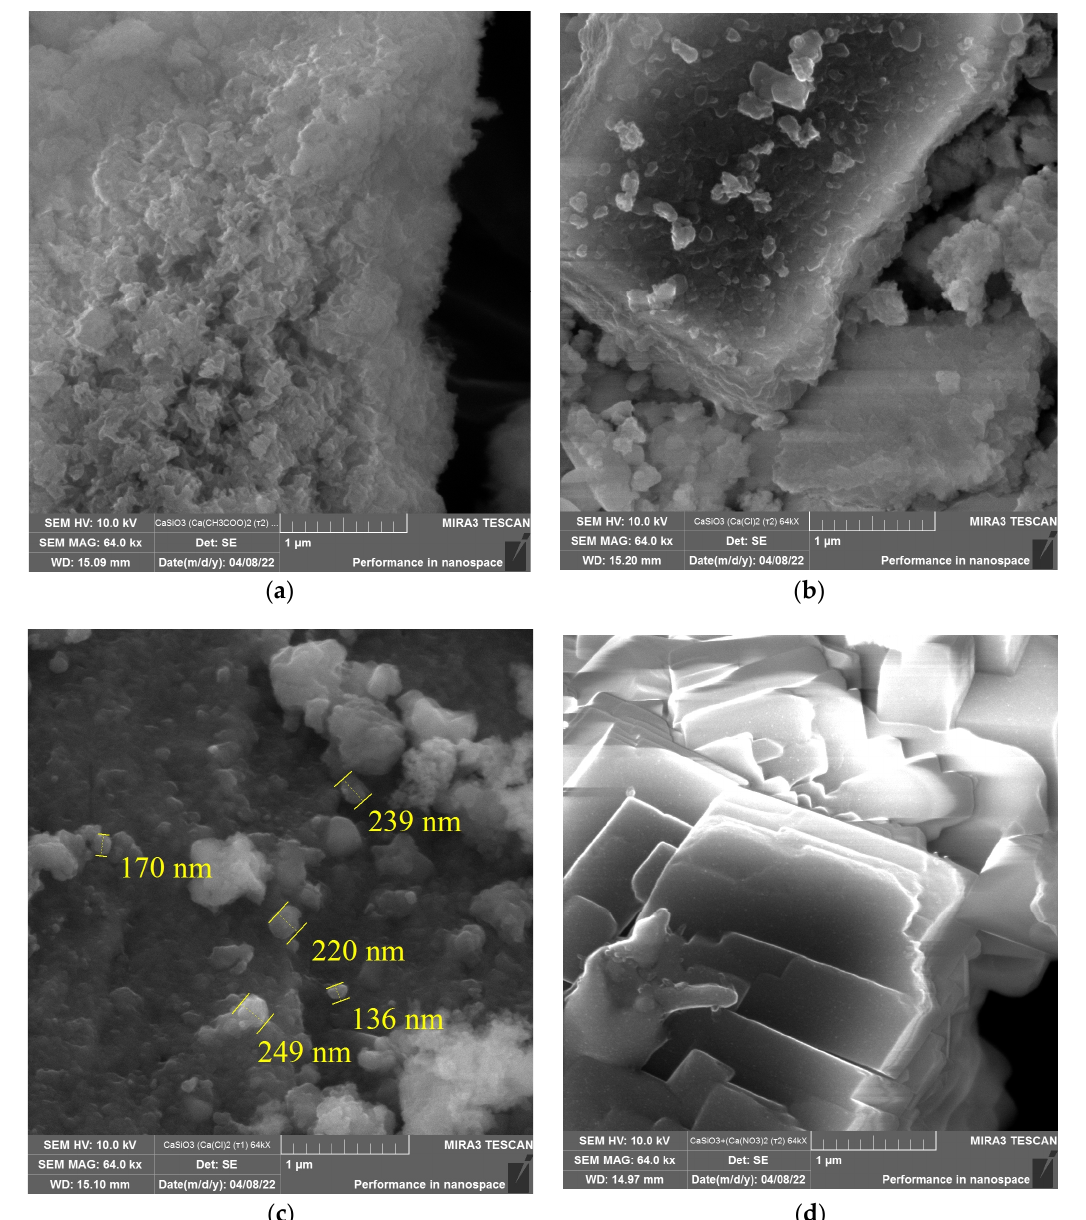
Figure 2. SEM micrographs of calcium silicate nanoparticles obtained from: ( a ) calcium acetate, ( b ) calcium chloride, ( c ) calcium chloride (other section), ( d ) calcium nitrate.